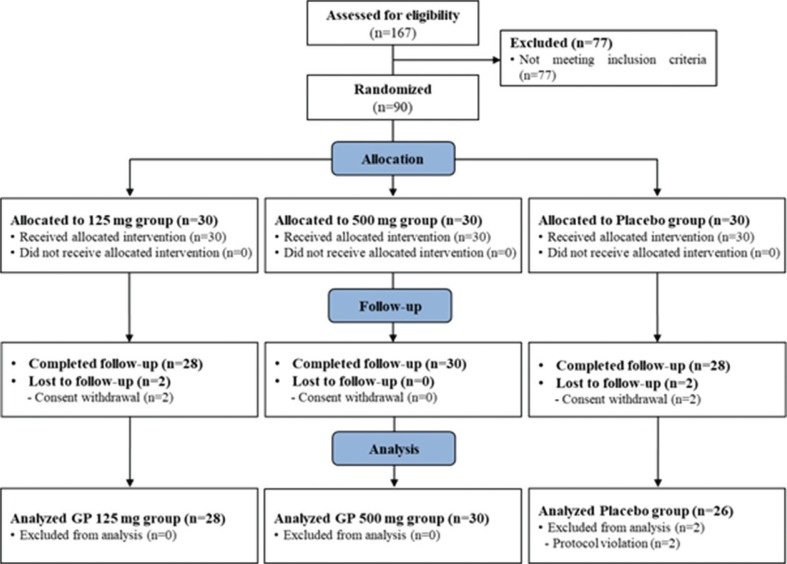
Flow diagram of the participants in this human study.